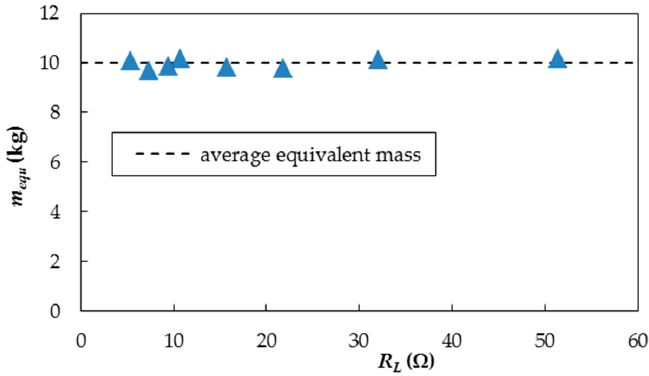
Figure 5. Equivalent mass m equ versus load resistance R L .